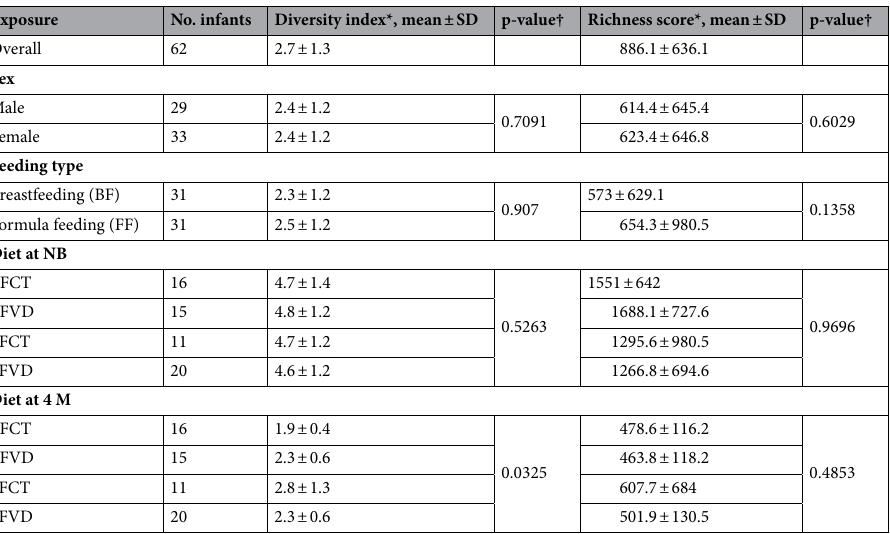
Table 3. Richness and diversity of fecal microbiota in infants, by early-life exposures. *Diversity was measured by Shannon index, which evaluates both the number of species and evenness of each group. Richness was measured by Chao1 score, which evaluates the number of different species present; † Mann–Whitney two-tailed test was used to measure variance in sex, antibiotics treatment group, which Kruskal–Wallis test was used to measure variance in mode of